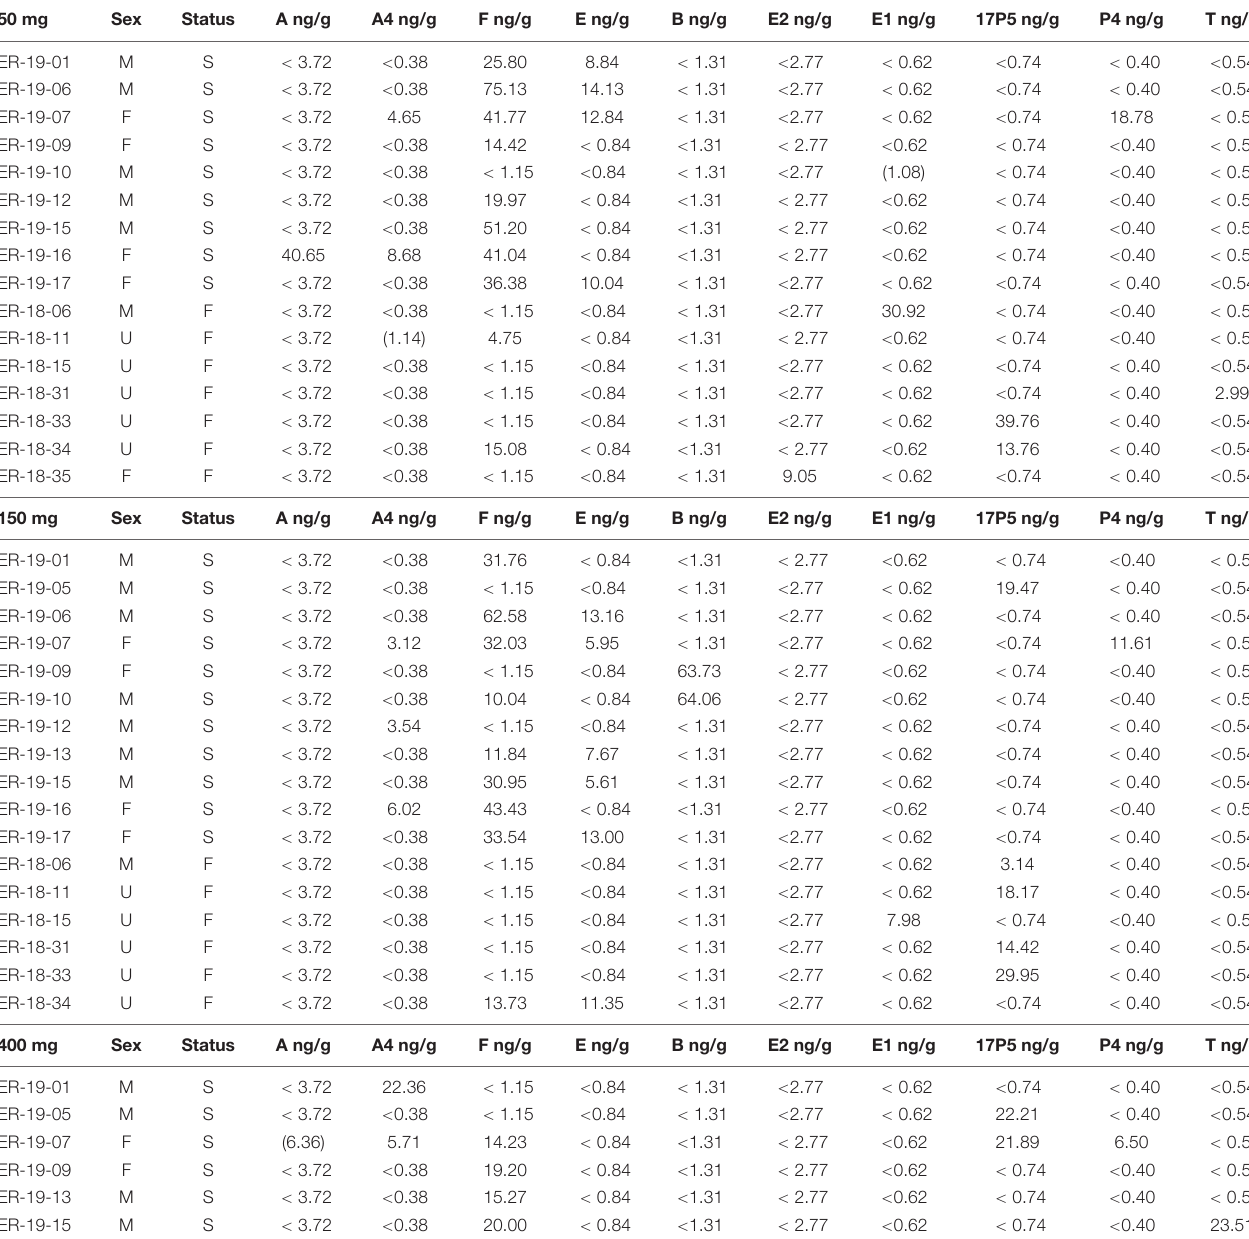
TABLE 3 | Hormone panel in 50, 150, and 400 mg gray whale